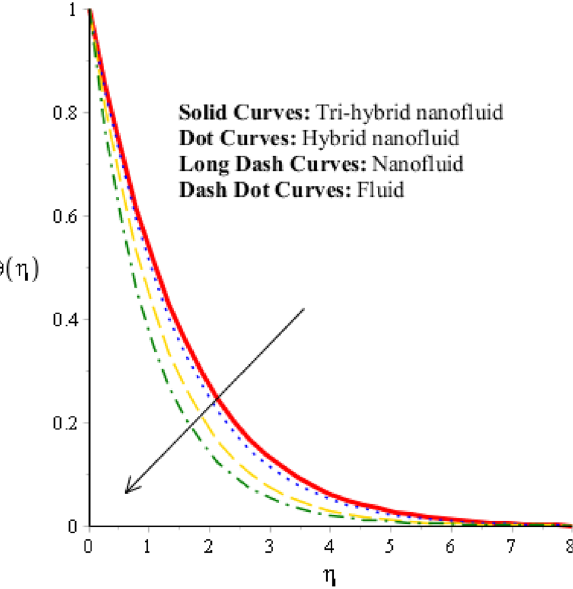
Figure 9. Comparative achievement among fluid, hybrid nanofluid, nanofluid and tri-hybrid nanofluid when α = 0.5, m = 0.3, Re = 4.0, we = 3.0, M = 3.0, K c = − 3.0, Pr = 206, H t = − 2.0, Sc = 0.0,